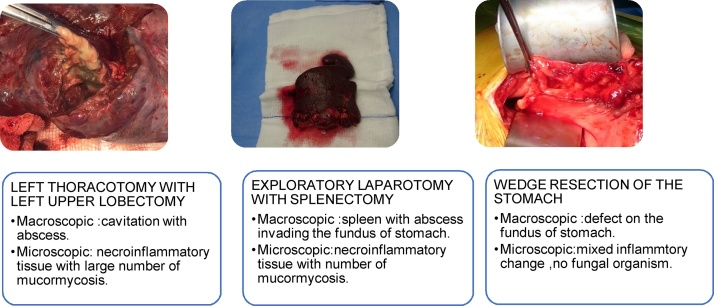
Surgical management.